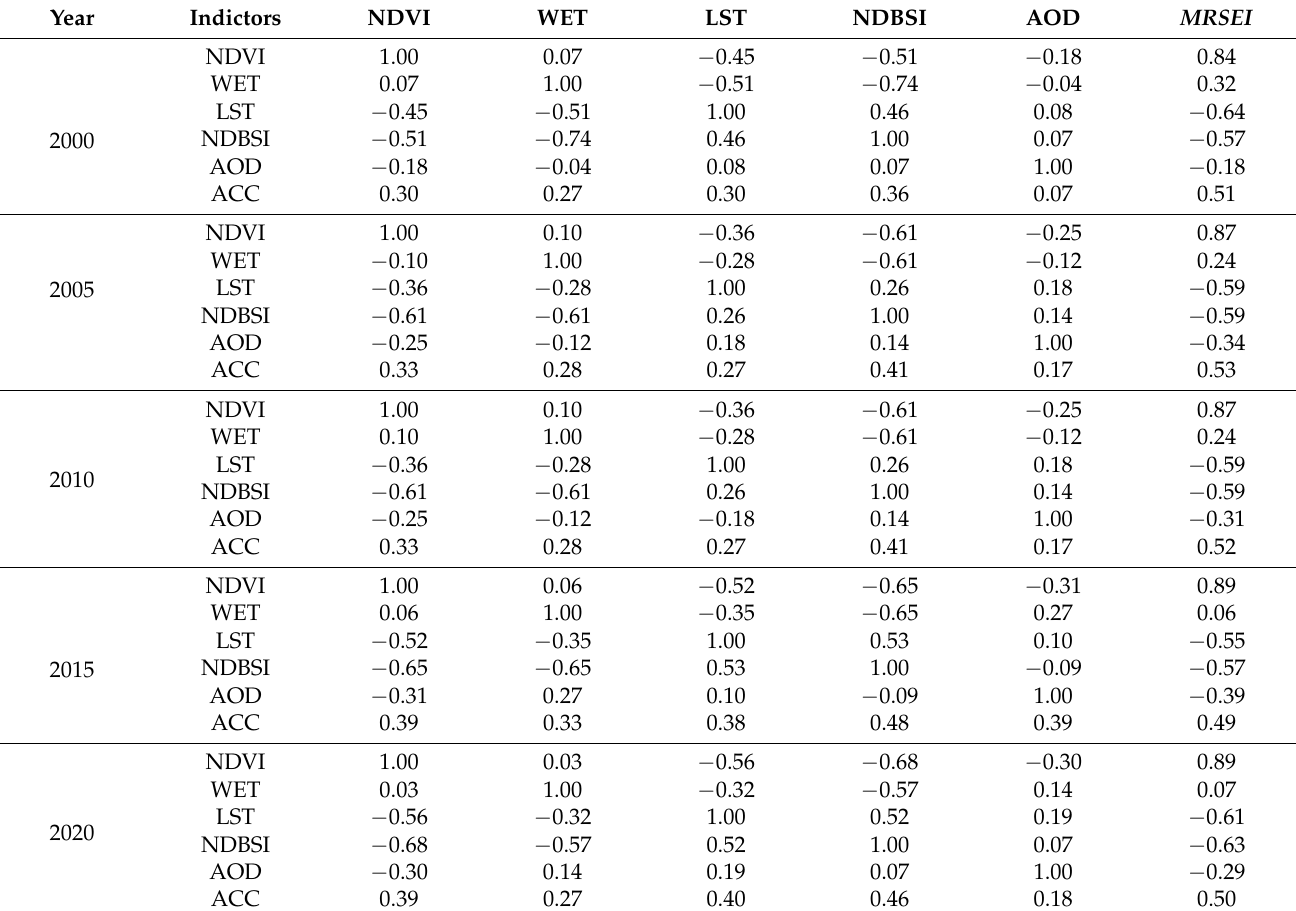
Table 4. Correlation matrix of